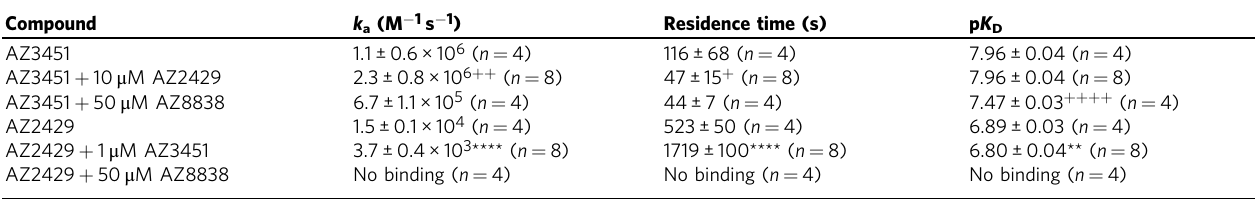
The kinetic rate constants and af fi nities have been extracted from the data through fi tting to a simple 1:1 single-cycle kinetic titration model as described under methods. Data are presented as mean values ± s.e.m. based on n independent experiments. Statistical analysis has been performed by the Student ’ s t -test or one-way ANOVA. + p <0.05, ++ p <0.01, +++ p <0.001, ++++ p <0.0001 compared to AZ3451. * p <0.05, ** p <0.01, *** p <0.001, **** p <0.0001 compared to